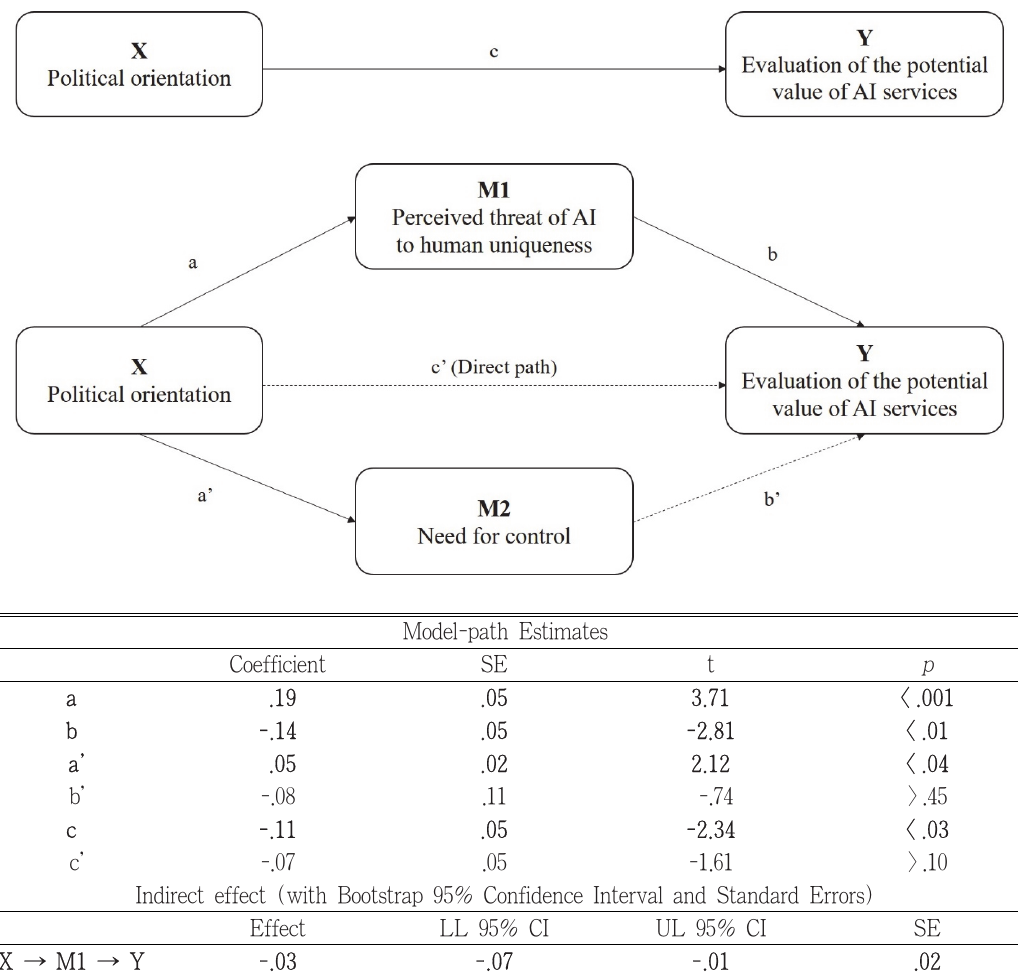
<Figure 1> The mediation effect of the perceived threat of AI to human